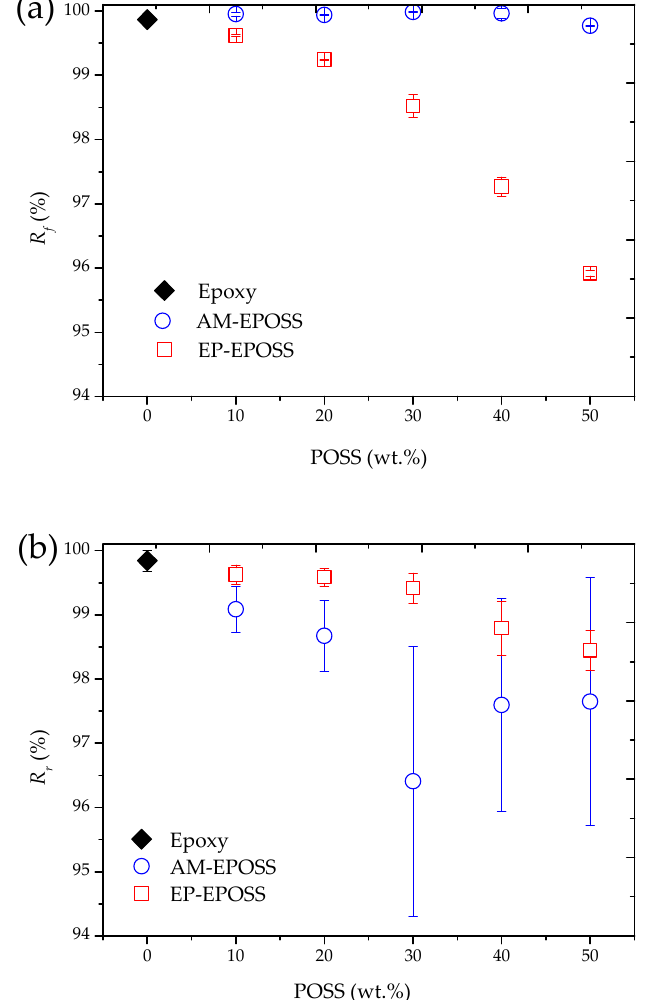
Figure 8. The effect of POSS type and content on ( a ) the shape fixity and ( b ) the shape recovery of EP–EPOSS and AM–EPOSS SMPs.